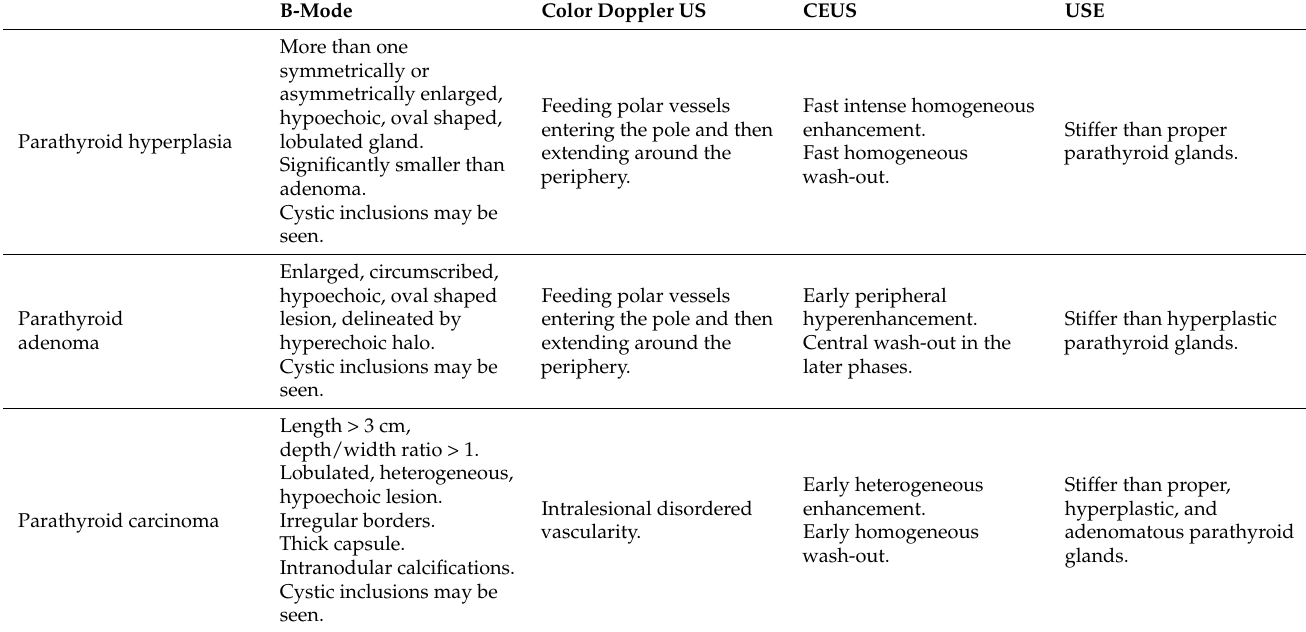
Table 1. Ultrasound (US) features of parathyroid lesions on B-Mode, Color Doppler, contrast- enhanced US (CEUS), and US-elastography (USE)